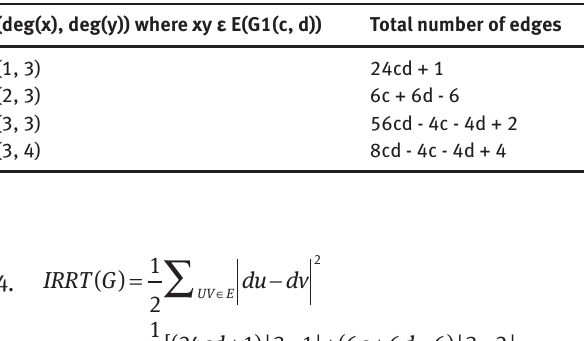
Table 1: Edge partition of 2 × 2 supercell of M1TPyP-M2 MOFs (M1, M2 = Fe and